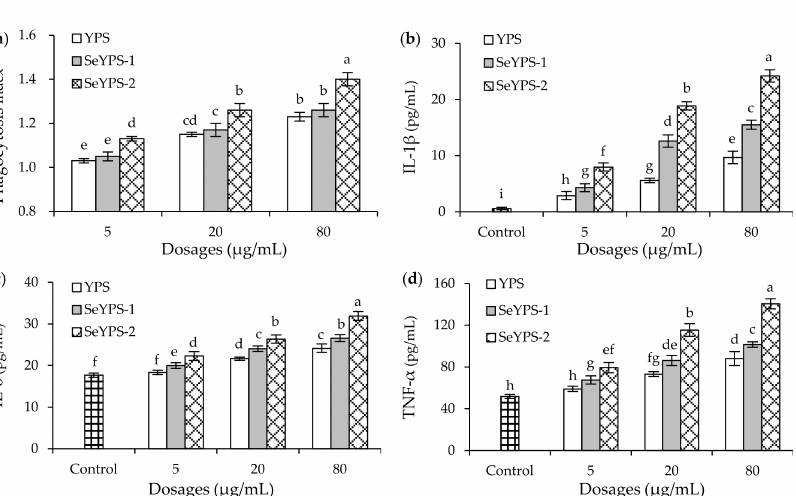
Figure 2. Phagocytosis index ( a ) and secretion levels of IL-1 β ( b ), IL-6 ( c ), and TNF- α ( d ) of the macrophages treated by SYP, SeYPS-1, and SeYPS-2 for 24 h. Different letters above the columns indicate that the one-way ANOVA of the mean values differs significantly ( p < 0.05).